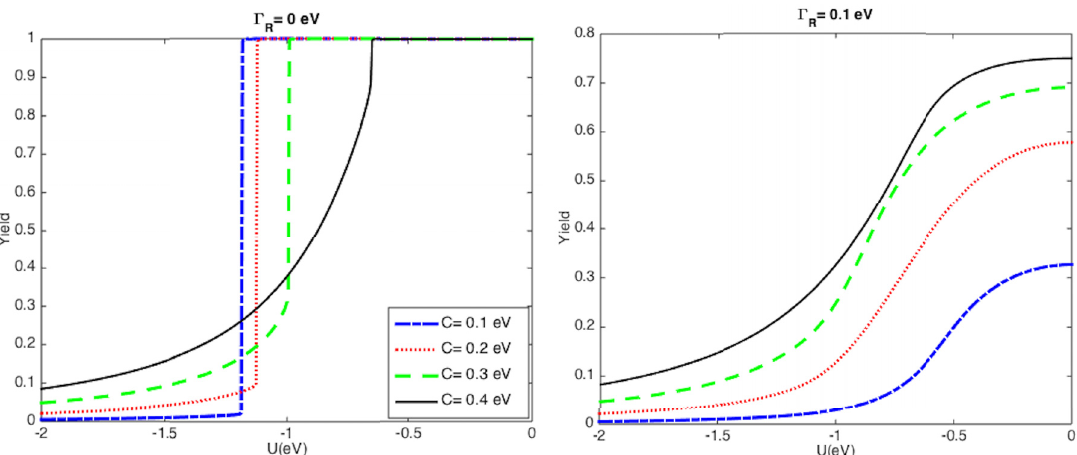
Fig. 6. Yield of a two-level photovoltaic cell as a function of interaction energy ( U ) for different recombination rate ( Γ R ) and coupling parameter ( C ).